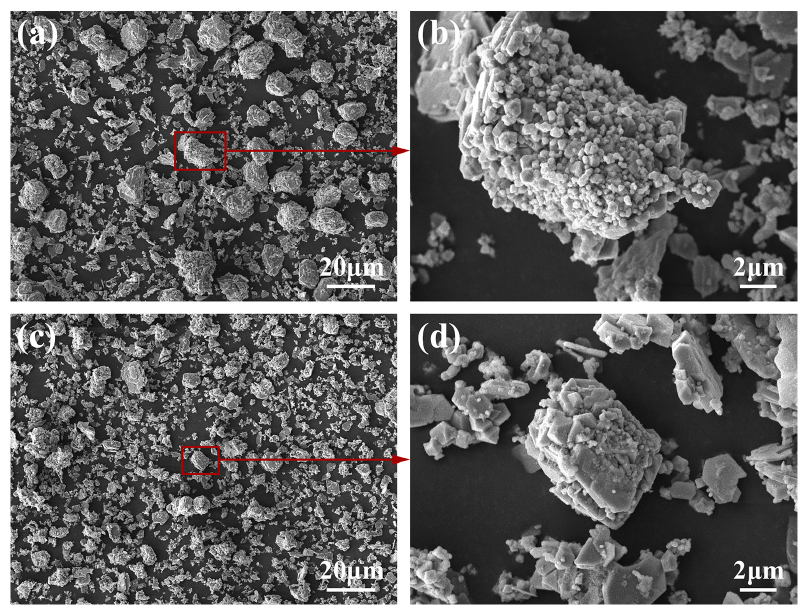
Figure 14. Microstructure morphology of extracted core–shell particles: ( a , b ) Al-4Ti-1D (10 μ m) and ( c , d ) Al-4Ti-1D (6 μ m).